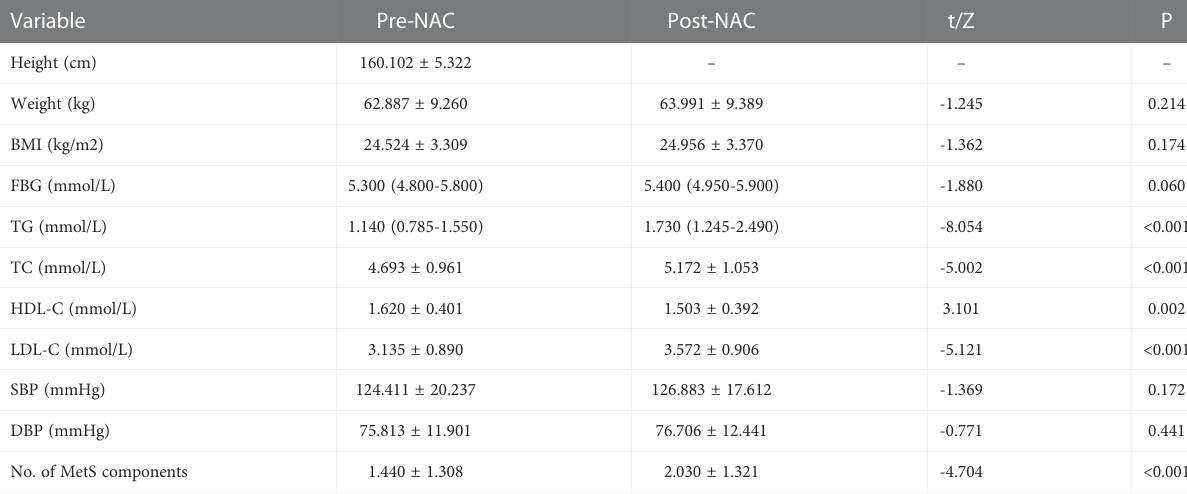
TABLE 4 Changes in metabolic parameters before and after NAC.